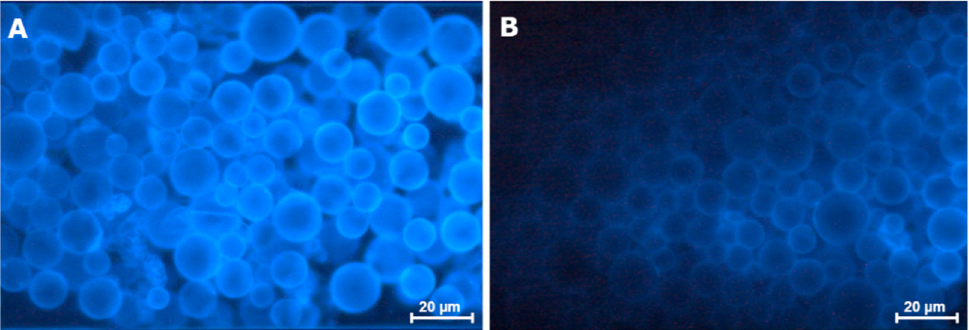
Figure 2. Serum HER2 protein levels measured using nanoparticles coated with an anti-HER2 antibody. ( A ) The nanoparticles were coated with a fluorescent anti-HER2 antibody (CB11), allowing quantification of serum HER2 expression levels in cats with HER2-positive mammary carcinoma (3+ score), by comparison with a ( B ) control serum sample from a healthy animal. This experiment corresponds to preliminary results from a recent study (data not published; 400× magnification).